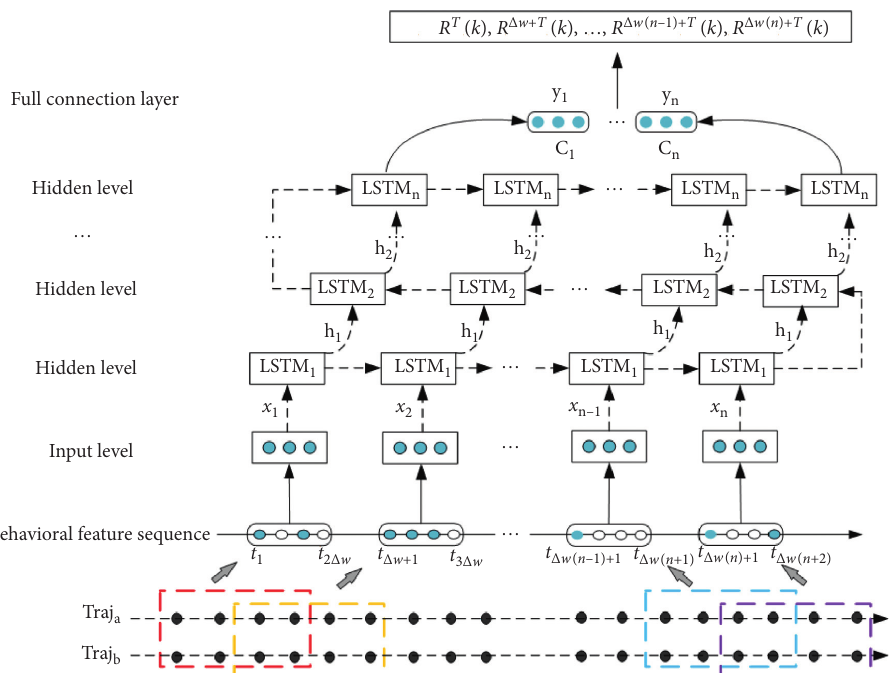
Figure 5: The model framework of ship encounter risk prediction.